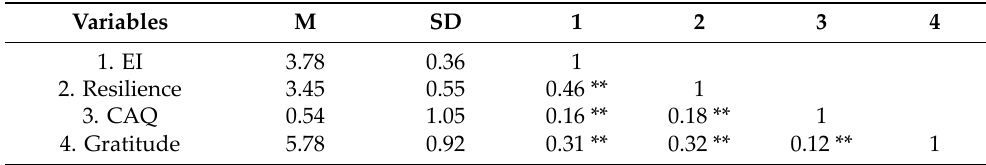
Table 5. Descriptive statistics and correlations between variables.